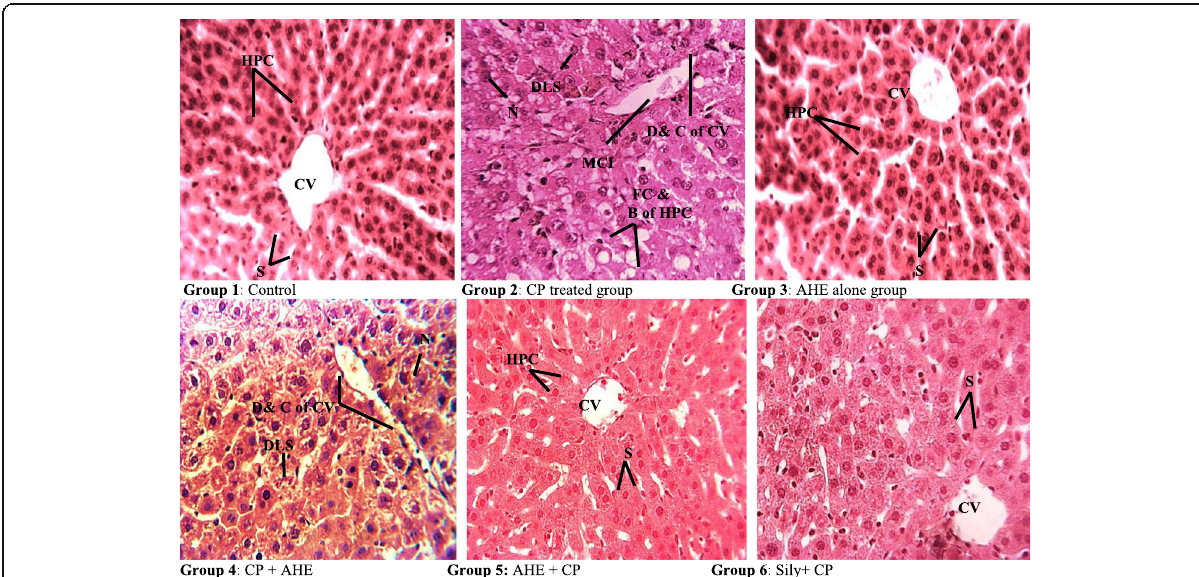
Fig. 3 Histopathological effect of Cisplatin and protective effect of AHE in rat liver. (H&E staining, magnification 40X). Group 1: Liver section from control rats showing normal liver morphology. Group 2: CP-treated rat liver showing enhanced cellular lesions, loss of hepatic tissue structure arrangement and collection of inflammatory cells. Group 3: Represents liver section from AHE alone treated rat liver. Group 4: AHE post-treatment showed low density of cellular lesions. Group 5: AHE Pre-treatment results in significant protection against CP induced hepatic injury. Group 6: Showed protective effect of Silymarin treatment. AHE, A. hydaspica ethyl acetate fraction, CP-Cisplatin, HPC-Hepatocytes, CV-Central venule, MCI-Monocytes nuclear cells infiltrations, D&C-Dilation and congestion, FC & B- Fatty changes and ballooning, DLS- Degeneration of lobular